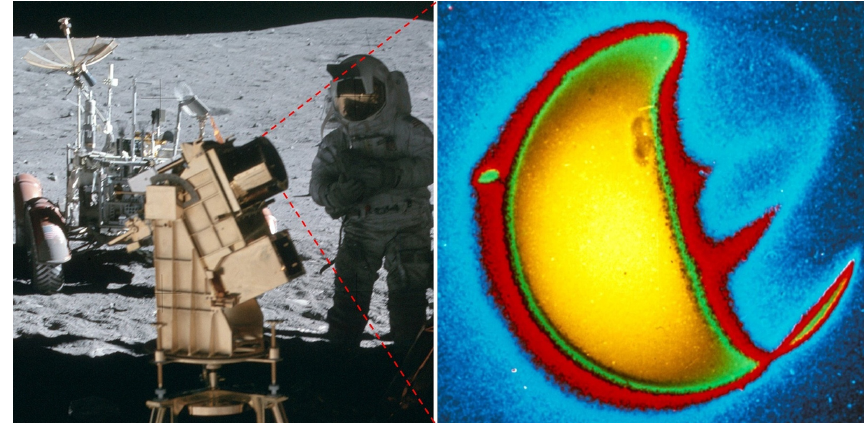
Figure 1. Left: a far-ultraviolet camera and spectrograph was operated on the lunar surface during the Apollo 16 mission, April 1972 (credits: NASA, Apollo 16). Right: the Earth, photographed in far-ultraviolet light (1304 angstroms) by astronaut John W. Young. Credits: George Carruthers (NRL) and Thornton Page (JSC), Far UV Camera, NASA, Apollo 16; based on the image AS16-123-19657 (Mason, 2019).